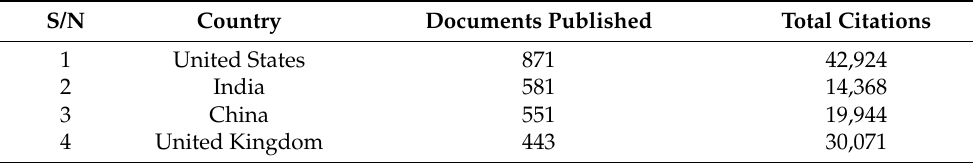
Table 5. Leading 20 countries based on published documents in the present research area through 2021. S/N Country Documents Published Total Citations 1 United States